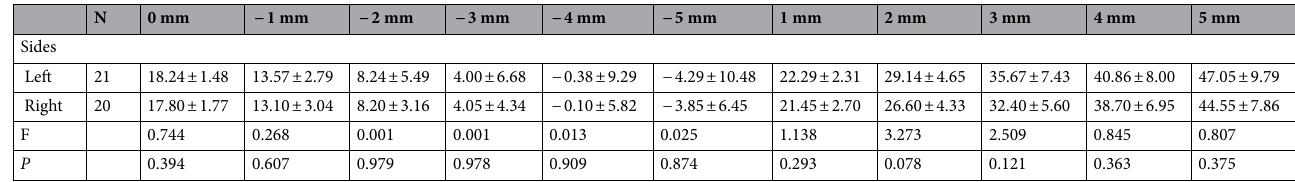
Table 5. The comparison of cup’s anteversion in different sides of normal developmental hips (x ±